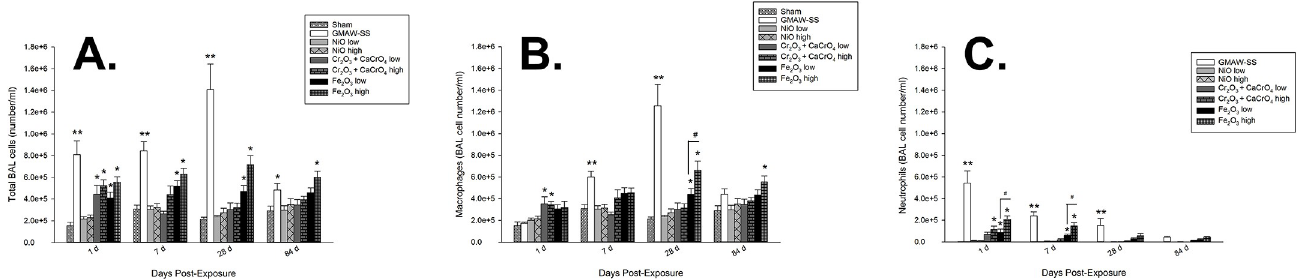
Fig 5. Total BAL cells (panel A), macrophages (panel B), and neutrophils (panel C) after exposure to GMAW-SS fume or metal oxides. No sham bars are present in panel c due to an absence of neutrophils in the sham group. � p < 0.0001 compared to sham; �� p < 0.0001 compared to sham and all other low dose groups; # p < 0.0001 compared to low- and high-dose metal oxides within a